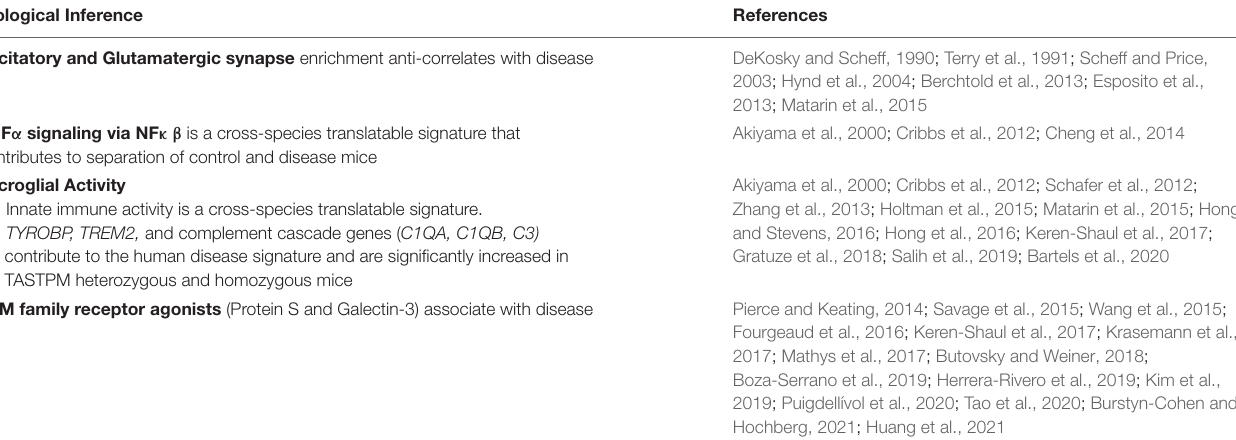
TABLE 1 | Biological inference summary from mouse-to-human cross-species analysis. Biological